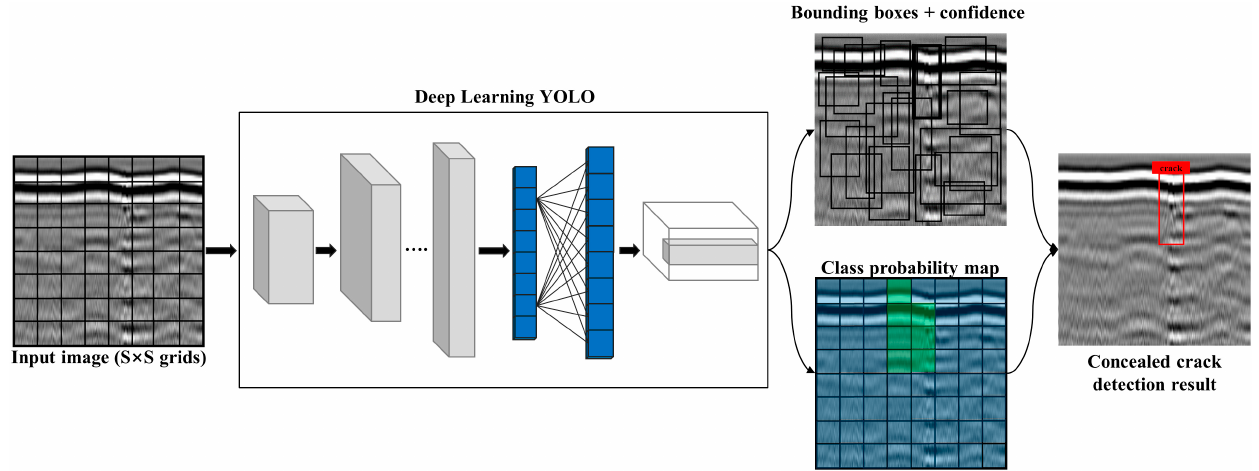
Figure 7. The workflow for detection method of the you only look once (YOLO) models. Table 5. Architecture and improvement of you only look once version 3 (YOLOv3) and YOLOv5. Model Backbone